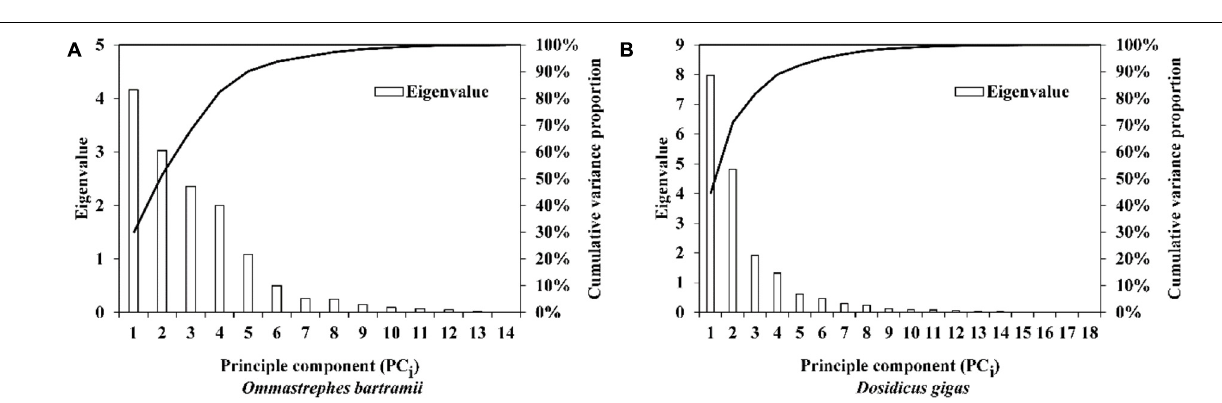
FIGURE 4 | A scree plot from principal components analysis for the monthly sea surface temperature (SST) dataset at the spawning and feeding ground of (A) Ommastrephes bartramii and (B) Dosidicus